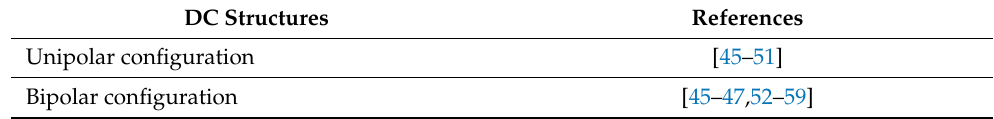
Table 2. Summary of the DC microgrid configurations and corresponding references.